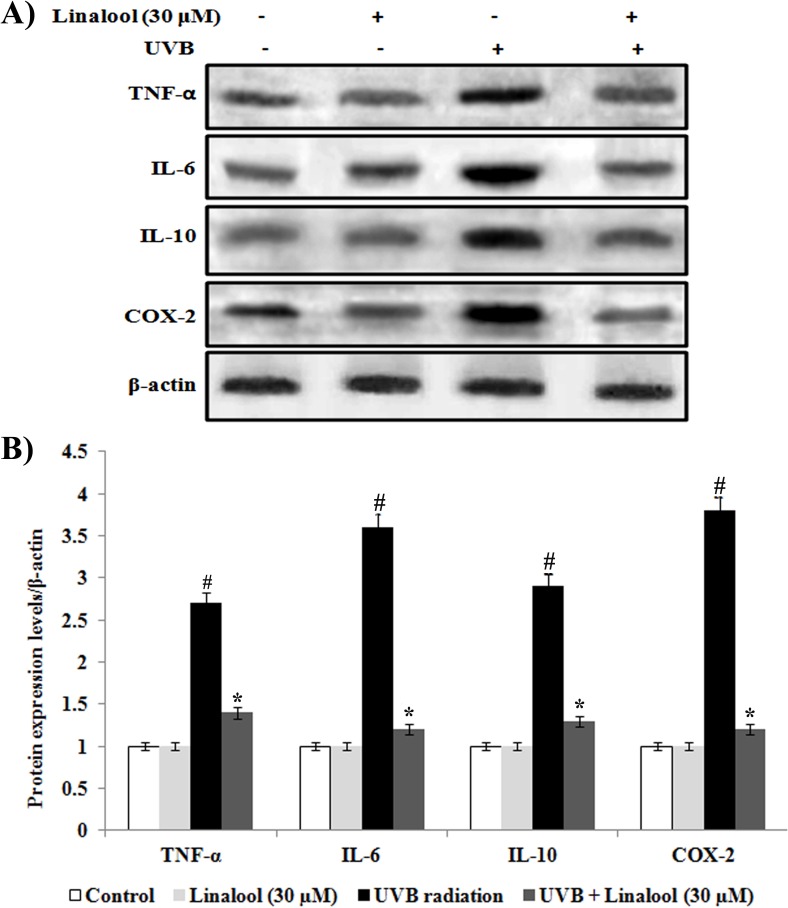
Effect of linalool on UVB-induced inflammatory markers expression in HDFa.(A) Western blot analysis of TNF-α, IL-6, IL-10 and COX-2 expression in HDFa. (B) The quantification of protein was performed by densitometric analysis using Image-studio software (LI COR, USA). The densitometry data represent means ± SD from three immunoblots and are shown as relative density of protein bands normalized to ß-actin level. Values not sharing a common marking (# and *) differ significantly at P < 0.05 (DMRT).